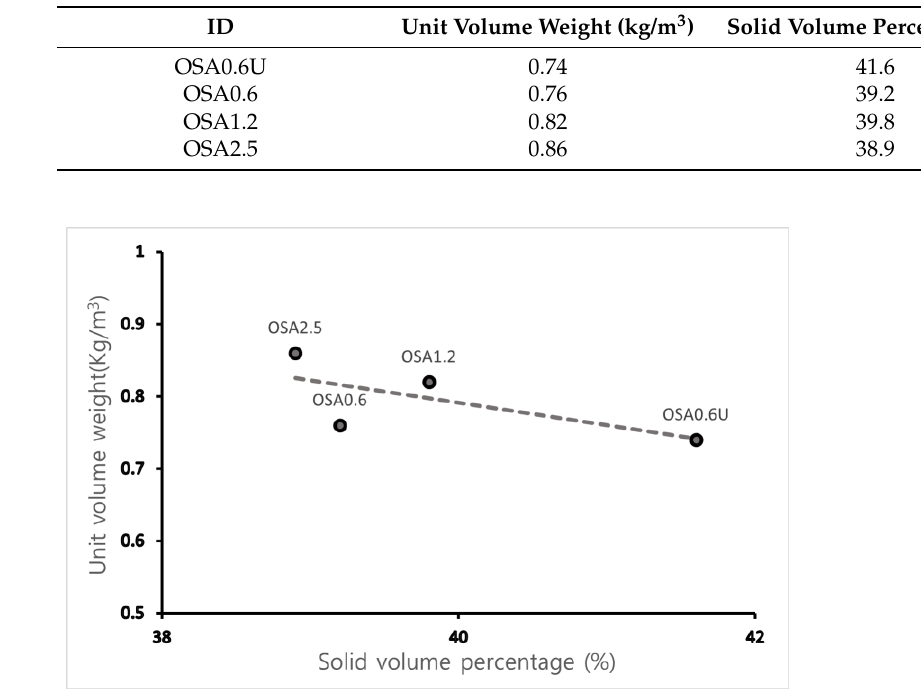
Figure 7. XRD of cement and the oyster shell aggregate.